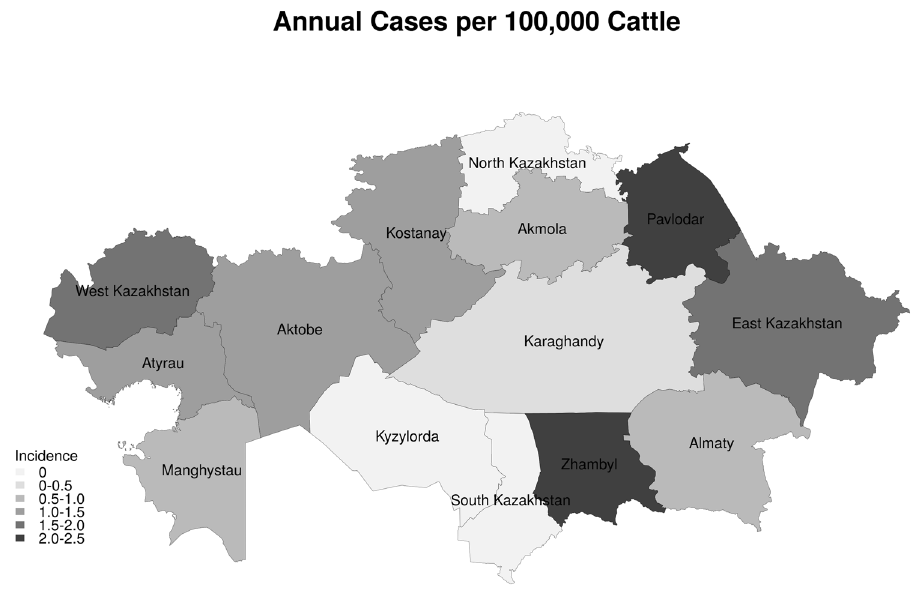
Fig 4. Annual incidence of rabies in cattle (confirmed cases per 100,000 cattle).